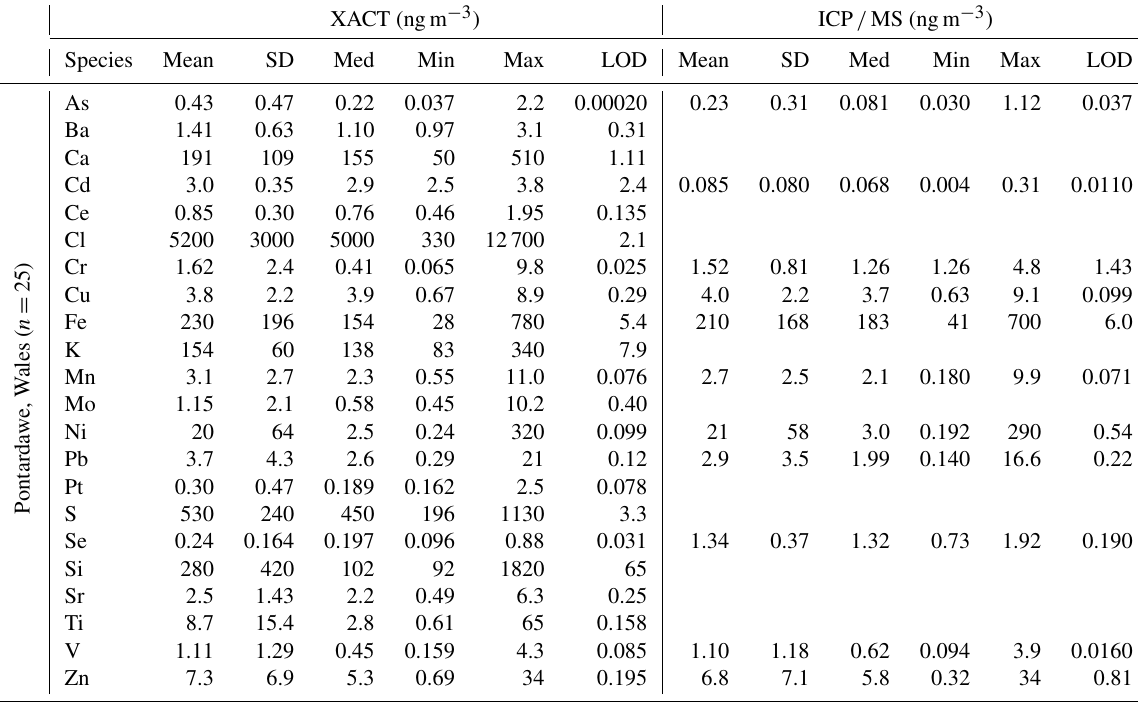
Table 4. Overview of Pontardawe, Wales measurements by XACT and ICP-MS (ngm − 3